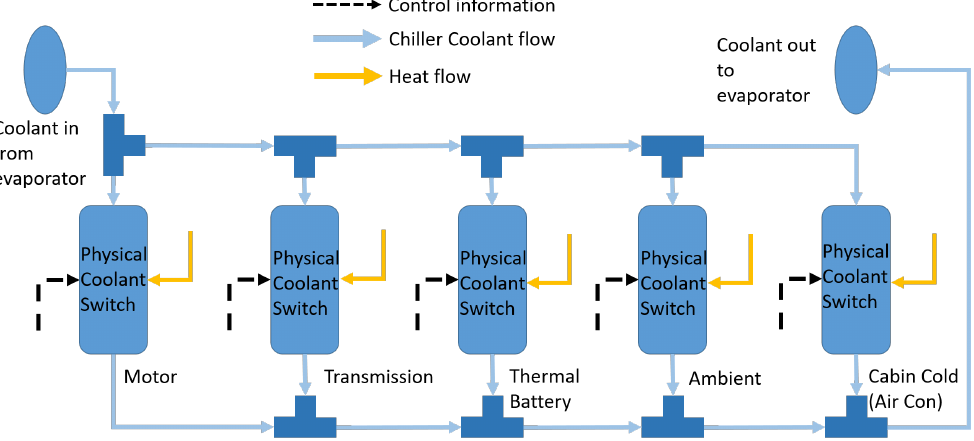
Figure 5. The chiller circuit is used for thermal exchange and extraction, i.e., extracting from the motor and inverter, the gearbox and driveline, ambient, heat battery. There is also the capability to cool the cabin and electric battery, if needed.